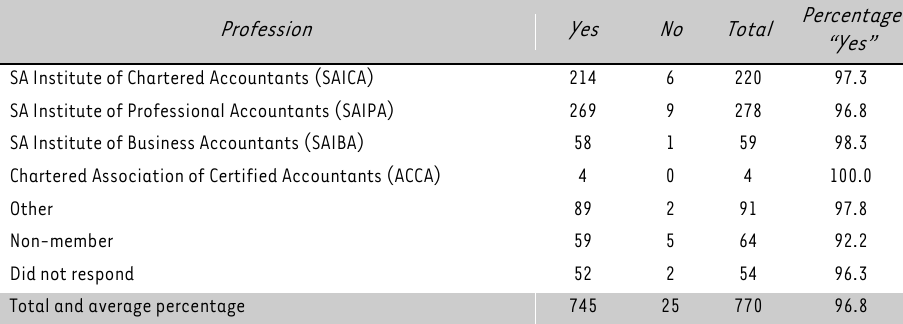
TABLE 4.1: Will micro GAAP represent fair presentation? (analysed by